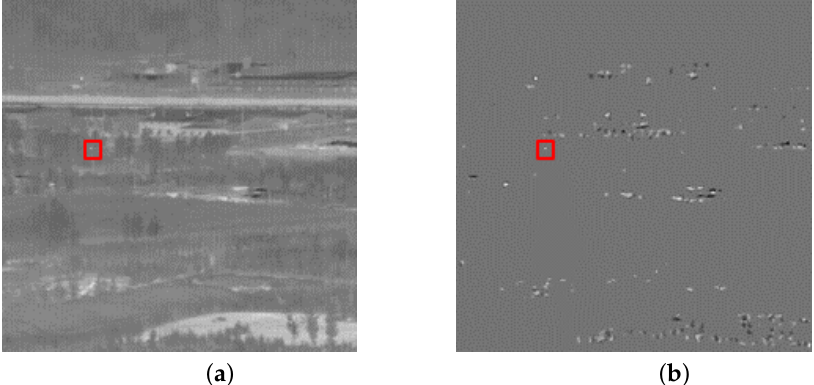
Figure 4. The image is filtered by a Laplacian; ( a ) is the original image and ( b ) is the image smoothed by the Laplacian filter